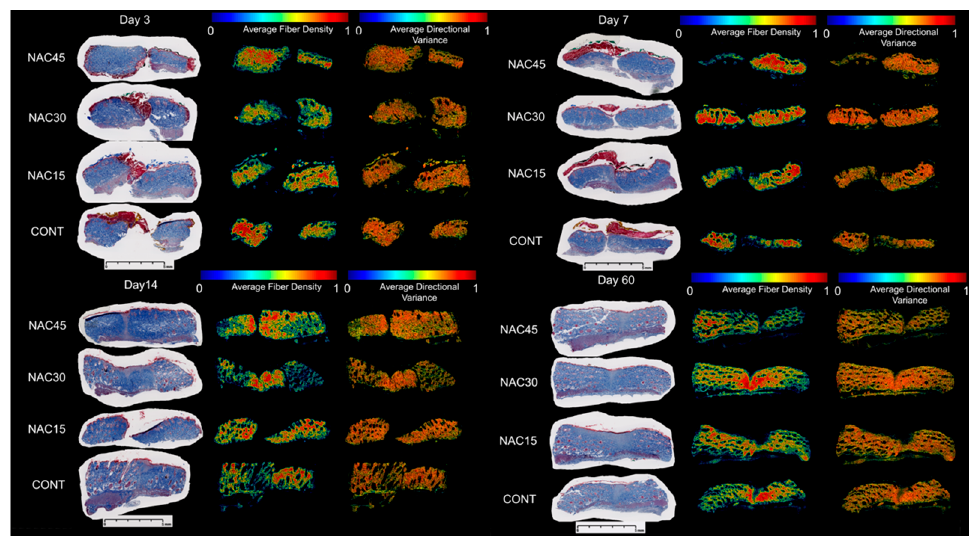
Figure 6. Graph represents directional variance distribution of collagen fibers in proximal scar areas ( A ) and scars ( B ) on the 7th and 14th days, respectively, in gNAC vs. CONT groups. Values ex- pressed as mean ± SD, * p < 0.05.